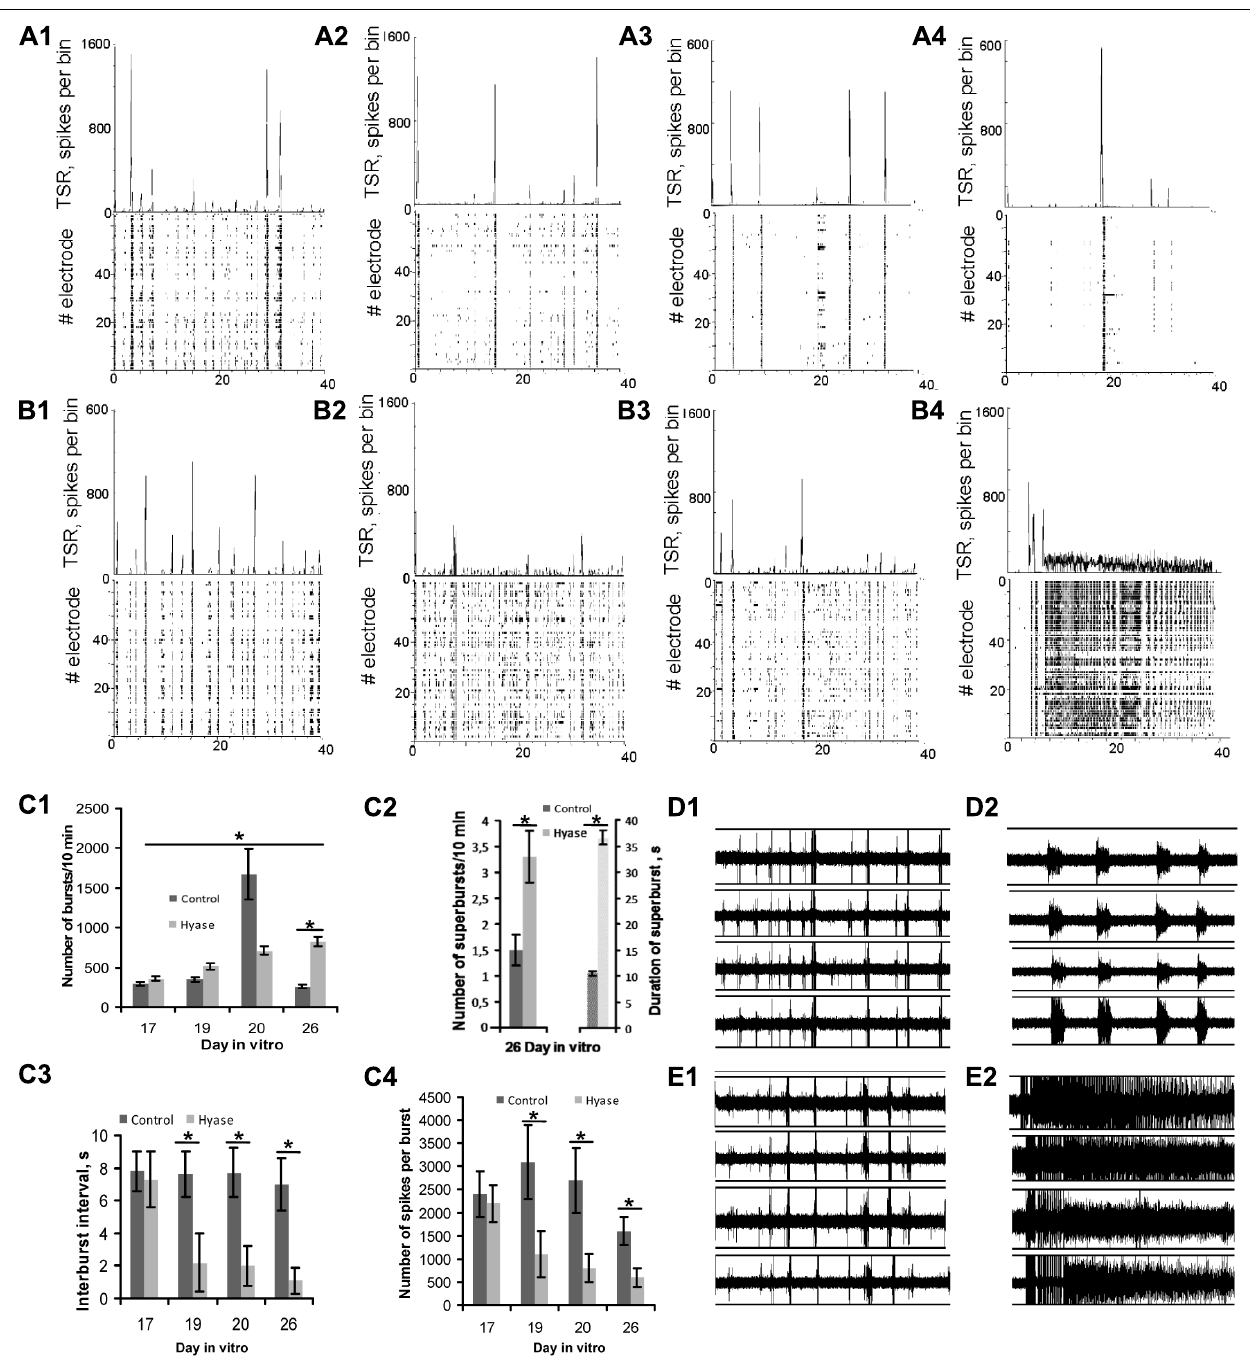
treatment (ANOVA; * p < 0.05; N = 5). (C2) Number and duration of network superbursts per 10 min on day 9 after Hyase treatment. (C3) Interburst interval (s) after Hyase treatment (ANOVA; * p < 0.05; N = 5). (C4) Number of spikes per burst after Hyase treatment (ANOVA; * p < 0.05; N = 5). (D1,D2,E1,E2) Spike recording from 4 electrodes of MED64 probes: (D1) intact culture on the 17th DIV; (D2) the same culture on the 26th DIV, 9 days after boiled Hyase application; (E1) intact culture on DIV 17; (E2) the same culture on DIV 26, 9 days after Hyase application.TSR, total number of spikes over all electrodes per 50 ms bin; Hyase,